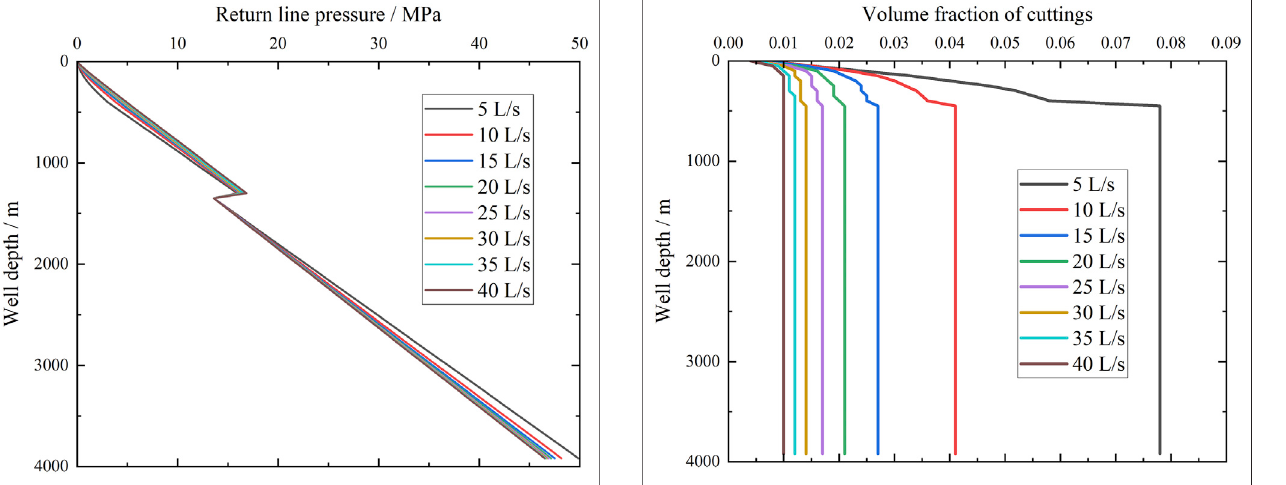
FIGURE 4 | Effect of drilling fl uid displacement on the volume fraction of cuttings inside the return